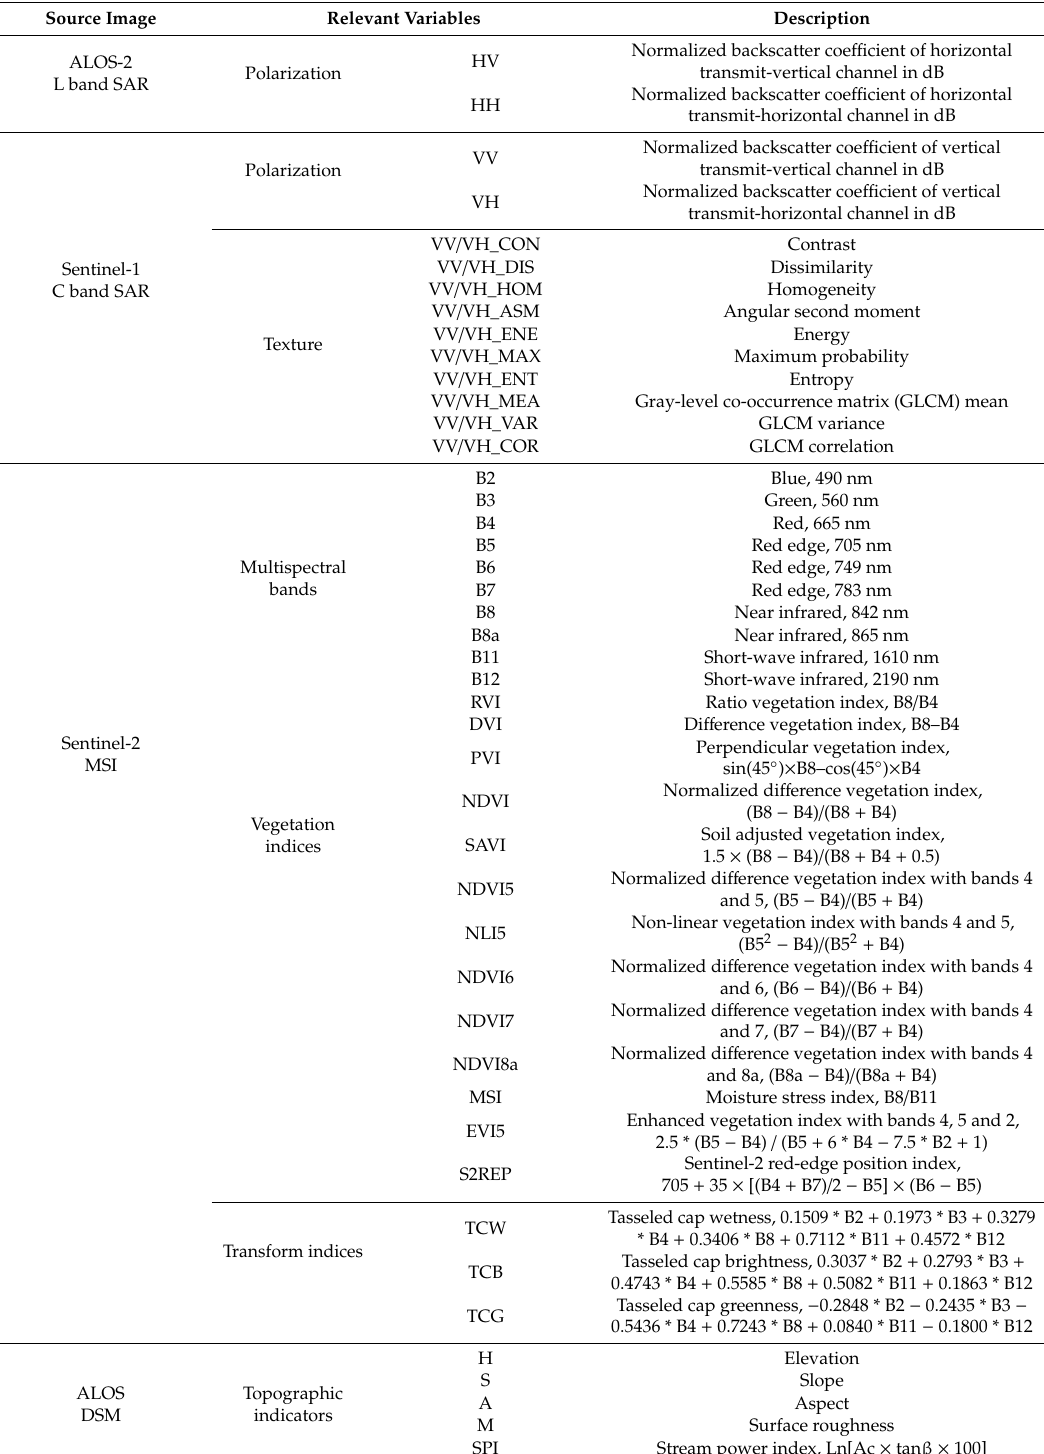
Table 2. Remote sensing indices from the ALOS and Sentinel series data for volume